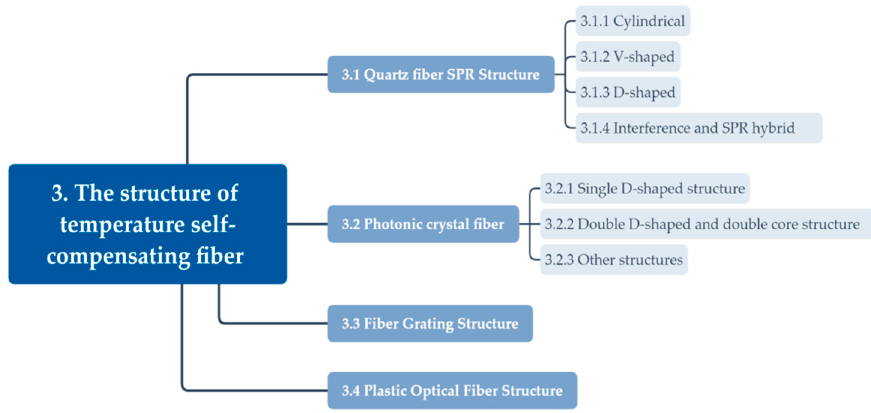
Figure 2. The overall structure of the temperature self-compensating fiber SPR sensor.